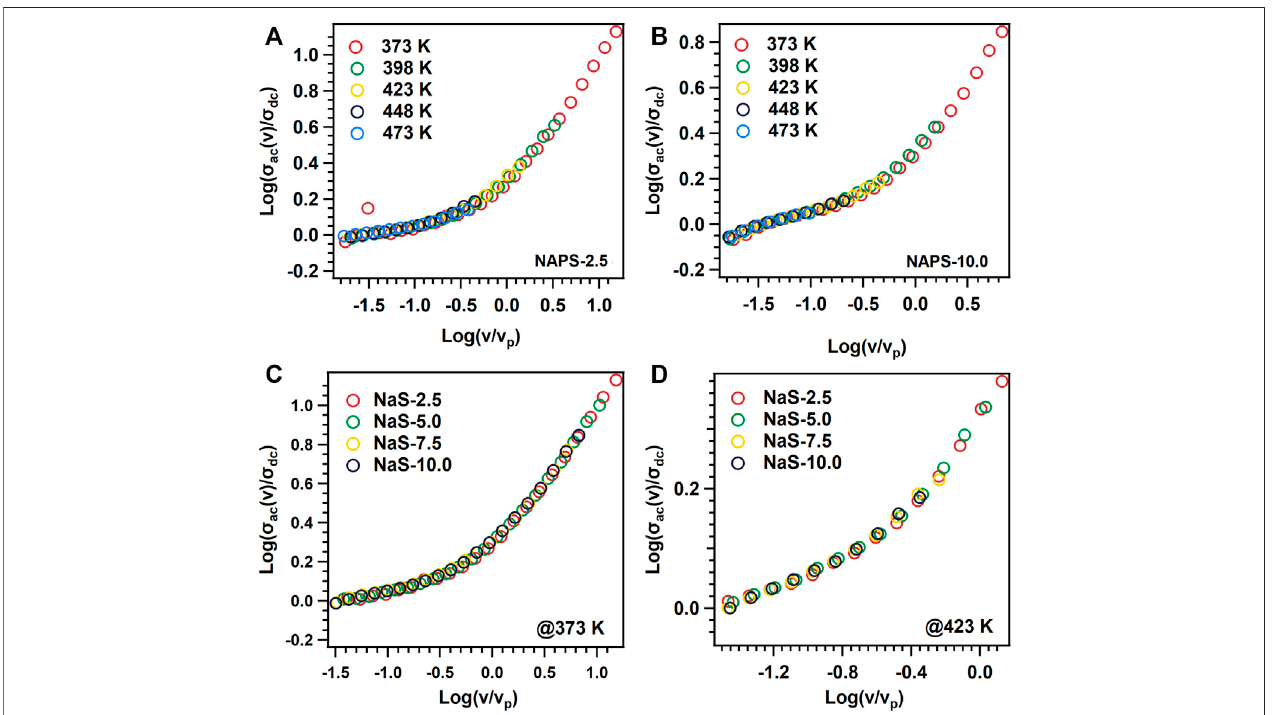
FIGURE 9 | ln ( σ dc T) vs ln ( ν h ) curve for different glass samples.